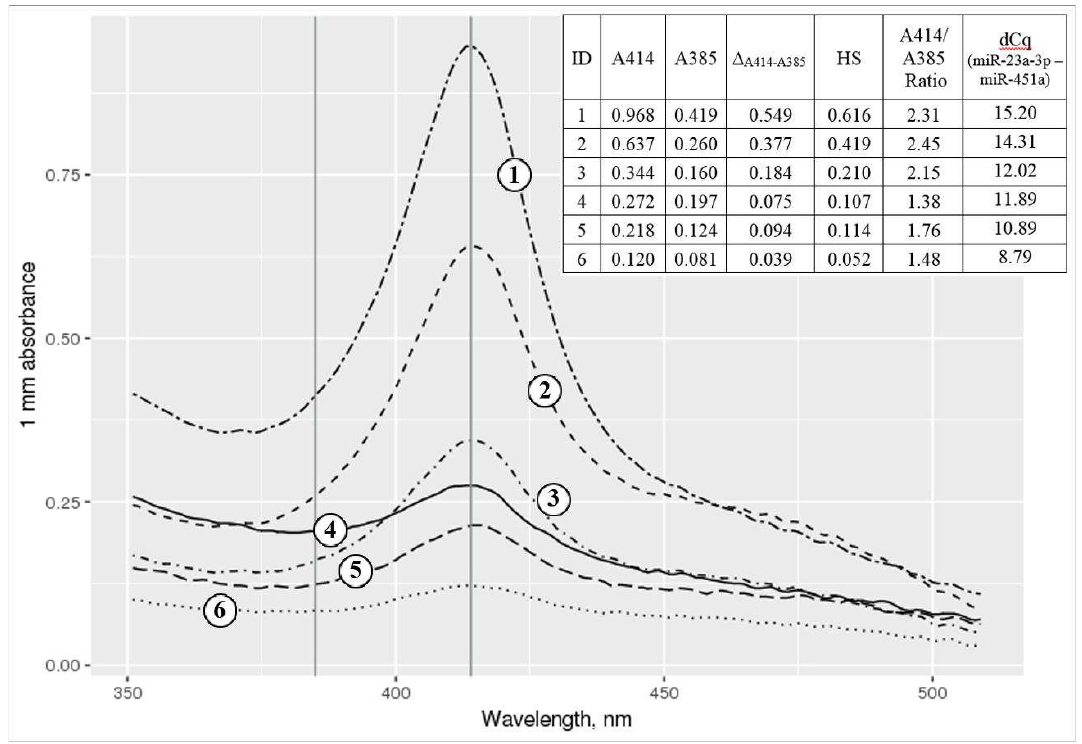
Figure 1. Spectrophotometric analysis of six different plasma supernatant samples in the 350-500 nm wavelength range. Left and right vertical lines correspond to 385 and 414 nm wavelengths. 1-2: hemolyzed samples with (1) and without (2) visually detected hemolysis, not included in the study; 3-6: samples with a low hemolysis degree, included in the study. Spectrophotometric data are supplemented by miRNA qPCR-based hemolysis assessment data. Table 2. Characteristics of hemolysis assessment in the study sample groups: PAF: 30 PAF patients; HT: 30 hypertensive patients without AF; CONTR: 30 healthy controls. A414 and A385: spectrophotometric absorbance at 414 and 385 nm wavelengths obtained during hemolysis assessment, respectively; HS: hemolysis score; dCq (miR-23a-3p–miR-451a) : Cq difference between miR-23a- 3p and miR-451a.